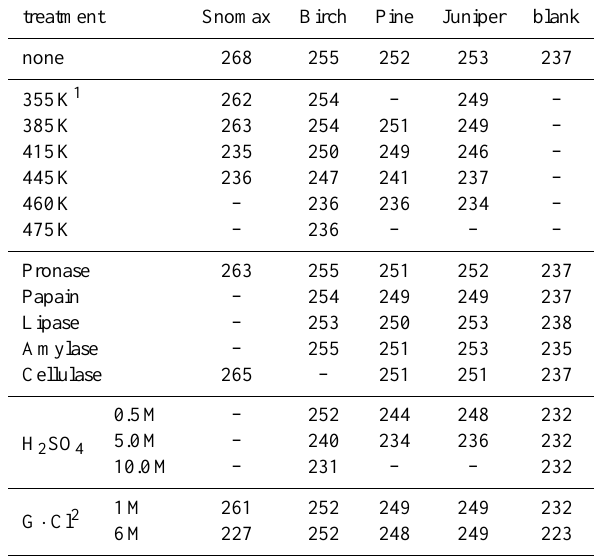
Table 2. Median freezing temperature dependence (in K) on ther- mal, chemical and enzymatic